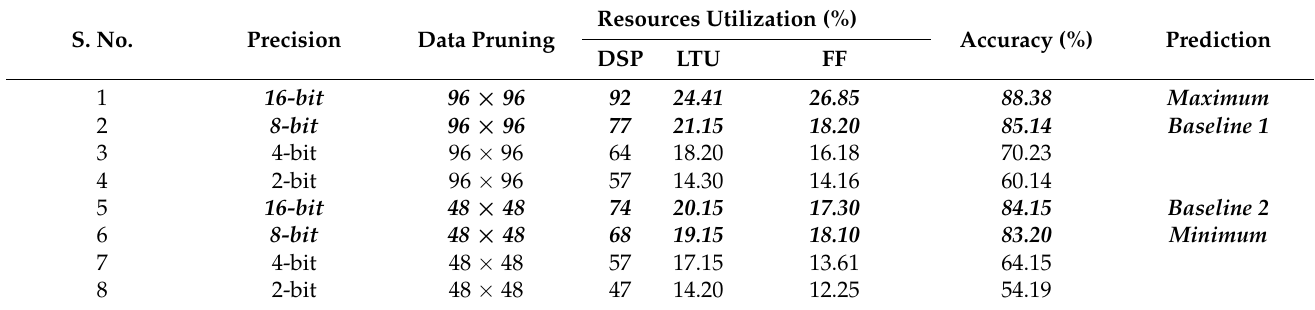
Figure 6. Schematic Flow Diagram of Sub-Optimal QSSN. Table 3. Design experiment’s forecast matrix based on Taguchi